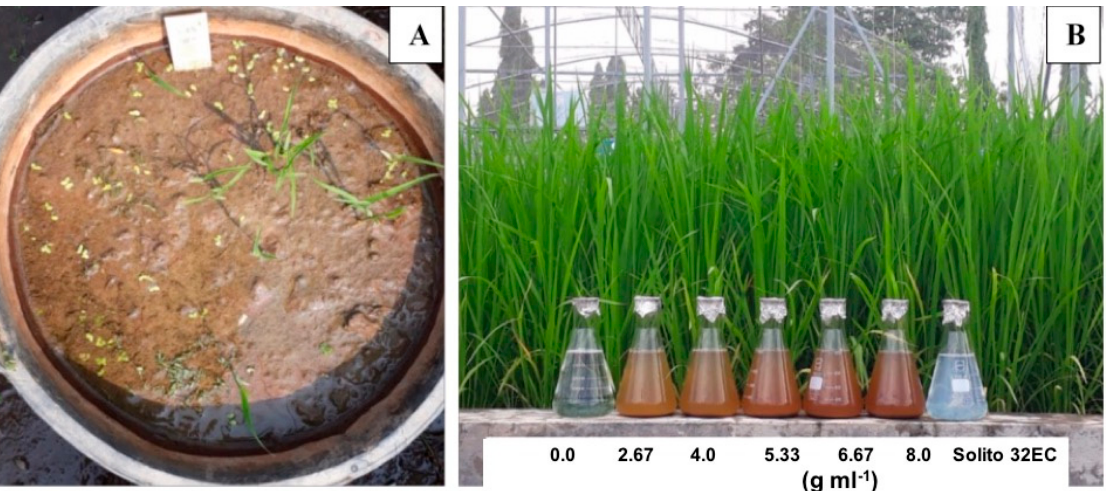
Figure 1. Photographs depicting experimental set up in the greenhouse. ( A ) Individual pot with pregerminated weed seed, one day before treatment; ( B ) rice extract at different concentrations (g mL − 1 ), water (0.0; negative control), and Solito (positive control).